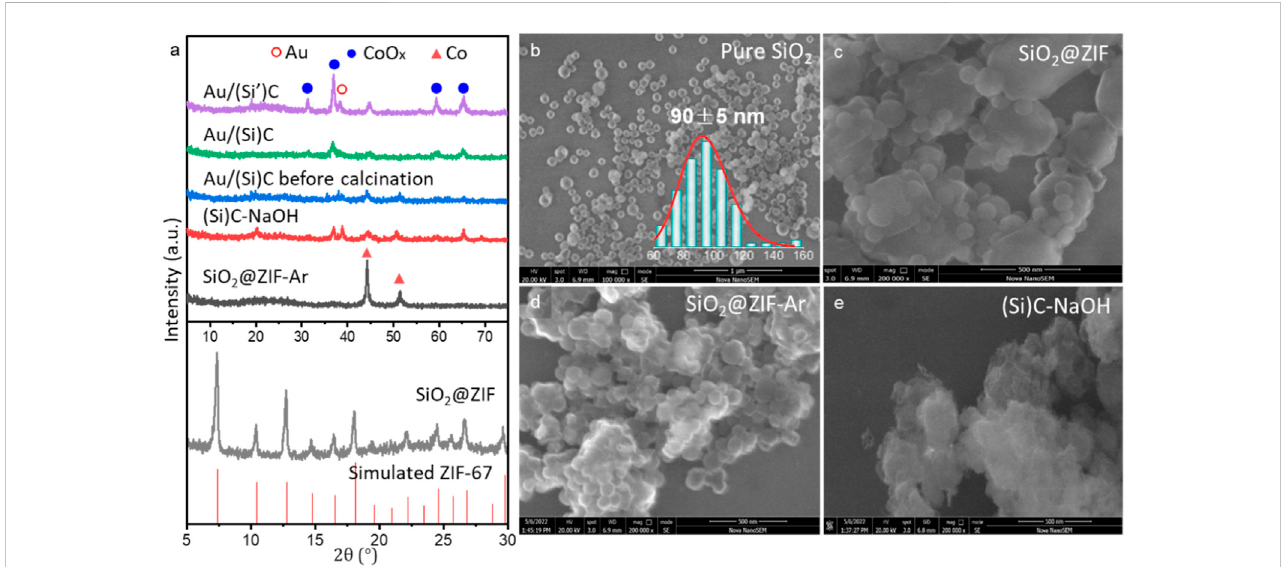
FIGURE 1 (A) XRD patterns and (B – E) SEM images of different samples during synthesis. Au/(Si ’ )C was synthesized using a similar method as that for Au/(Si)C, but based on silica with larger spheres (350